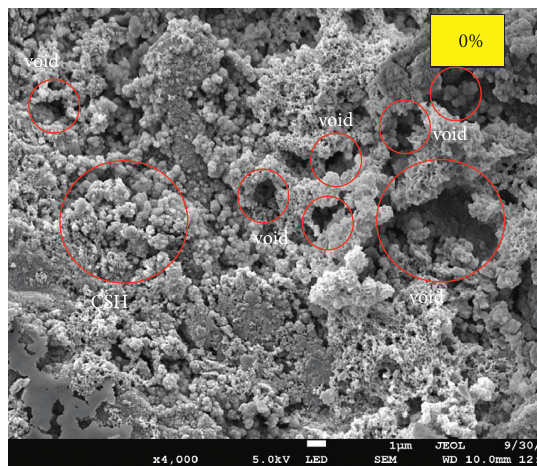
Figure 8: POC control specimen with many voids.